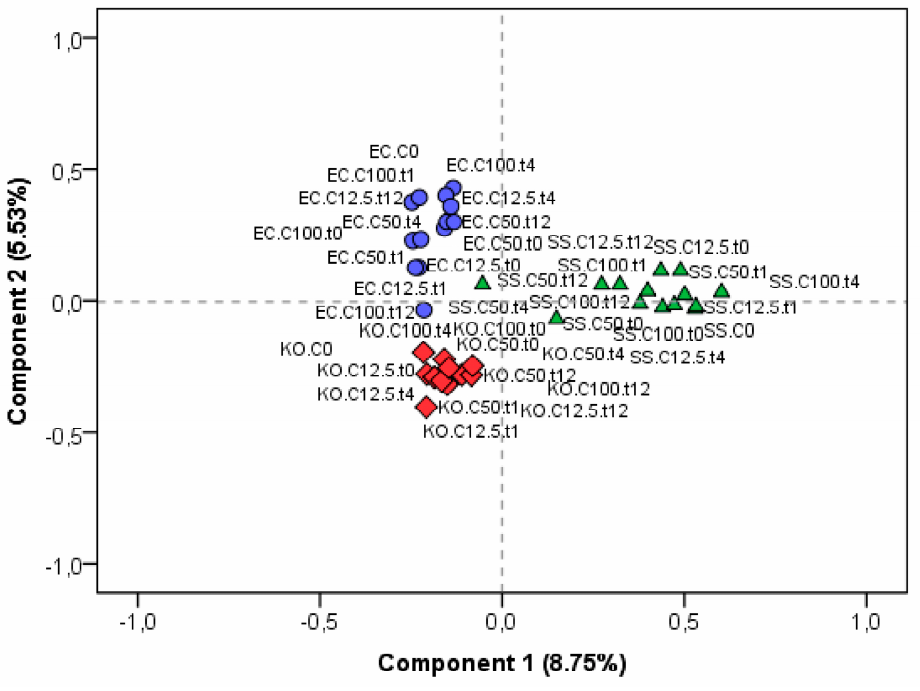
Figure 3. Principal component analysis (PCA) plot of protein ions profiles acquired by MALDI-TOF MS experiments, where diamonds, triangles, and circles represent K. oxytoca (KO), S. saccharolyticus (SS), and E. coli (EC), respectively.